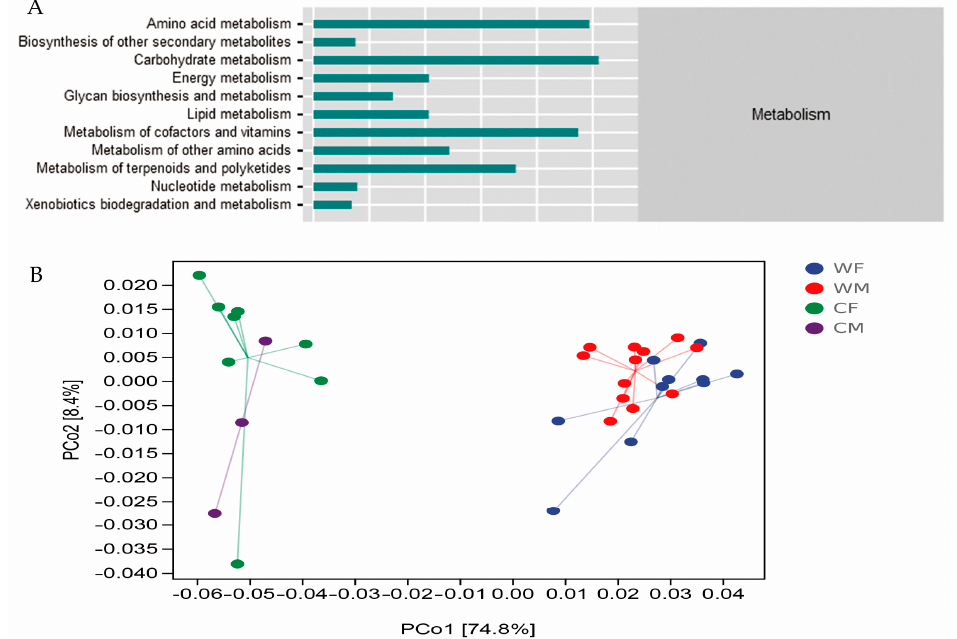
Figure 4. ( A ) Metabolic composition of secondary function pathways. ( B ) A PCoA plot based on weighted UniFrac distance metrics associated with a functional dataset. The colors represent sample sets of microbial functions (WF: n = 10, WM: n = 12, CF: n = 8, CM: n = 3). It was found that there were significant differences in the three metabolic pathways of glycan biosynthesis and metabolism (GBM), energy metabolism (EM), and metabolism of other amino acids (MAA) ( p < 0.05) (Figure 5).